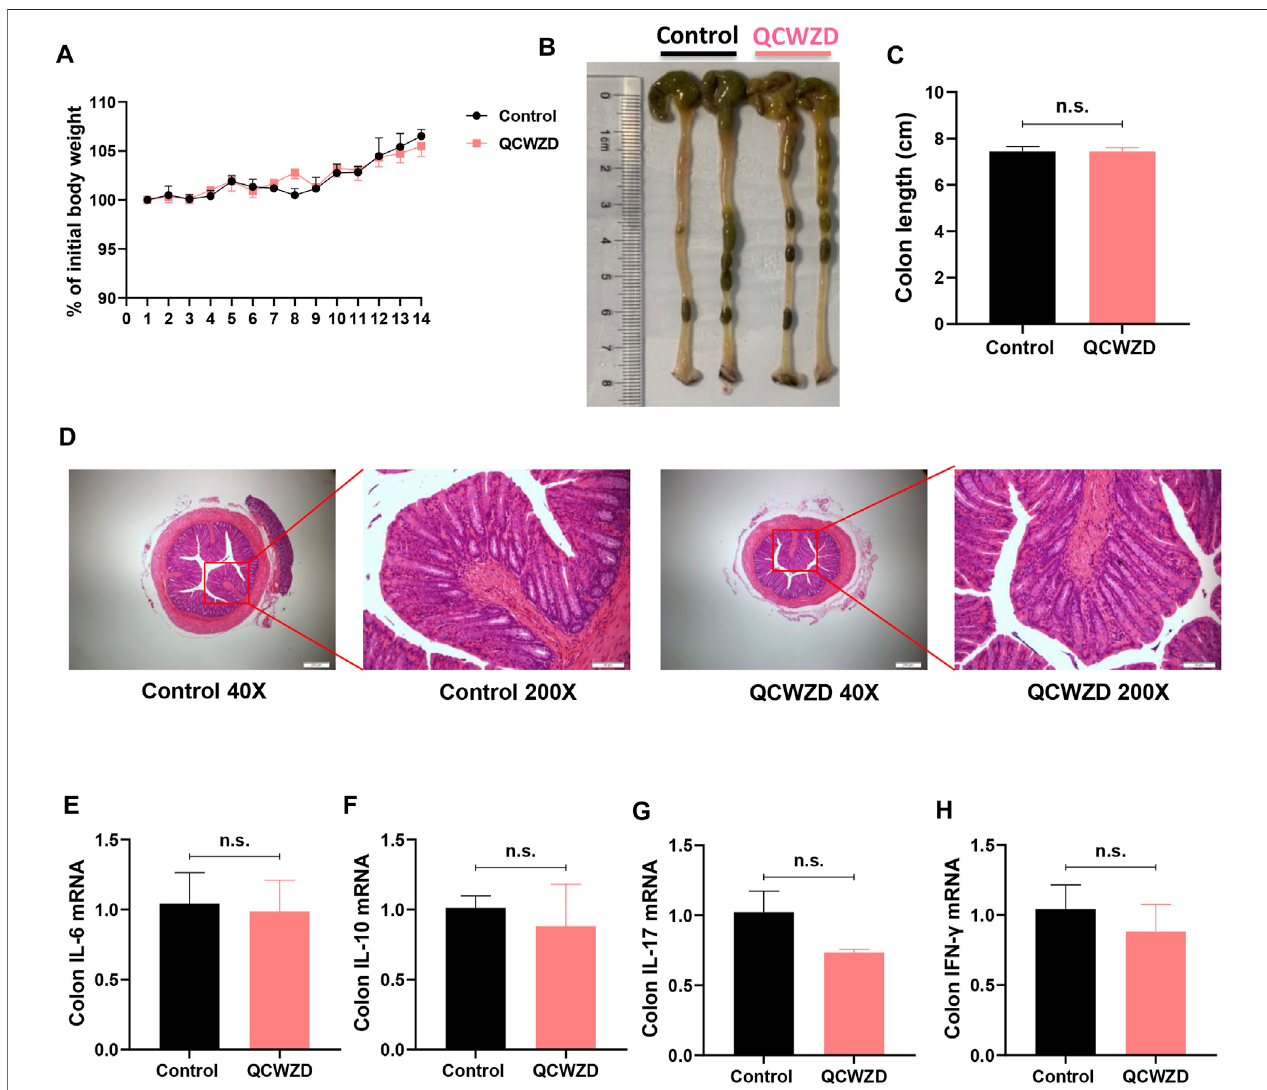
FIGURE9| OralTreatmentofQCWZDDoesNotProduceAnyApparentEffectsinChow-FedMice.Micewererandomlydividedintothetwogroups( n (cid:2) 5).Chow- fedmicewereeithertreateddailywithsterilewateror1.8 g/kg/dayQCWZDoverthecourseof14 days. (A) Bodyweight. (B,C) Colonlength. (D) Hematoxylinandeosin (H&E) stainingofthecolon. (F – I) RT-qPCRanalysisforin fl ammatoryrelatedcytokinesIL-6,IL-10,IL-17,andIFN- γ .Thedatashownarethemean ± theSEM( n (cid:2) 5mice/ group) from one of two experiments performed showing similar results. Signi fi cance was determined by a Two-tailed Student ’ s t-test and ns means no statistical signi fi cance between the two